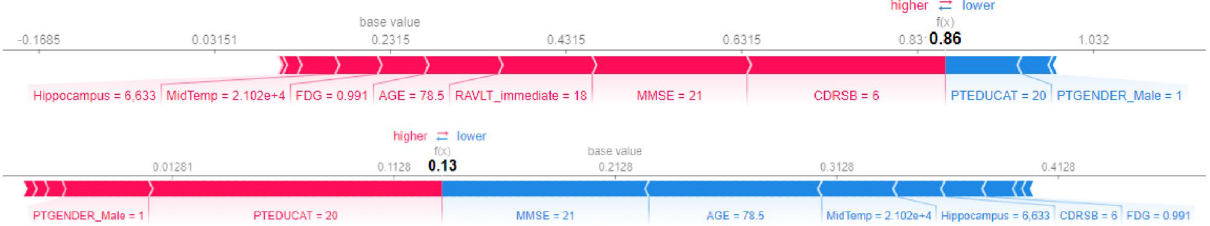
Figure 20. Comparison between features impact on the predicted (AD) and true class (LMCI) of a subject.